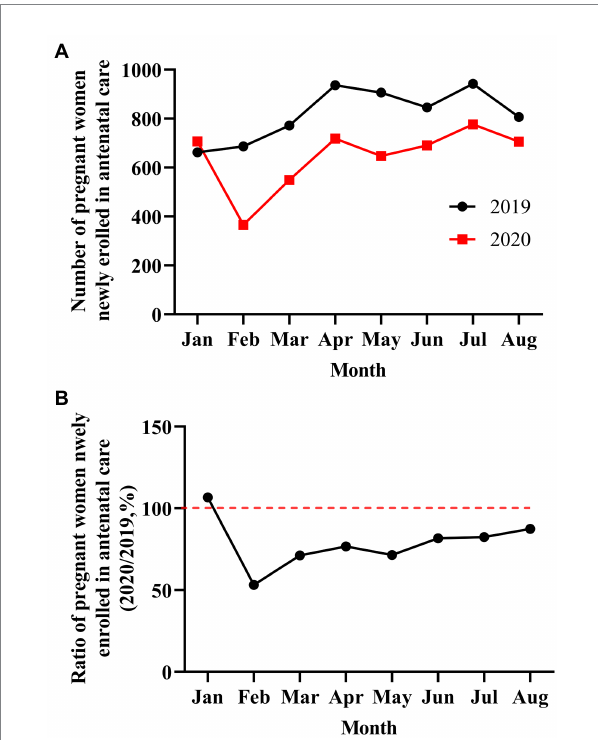
FIGURE 1 Number and ratio of pregnant women newly enrolled in antenatal care from January to August 2019 and 2020 (pre-and post- COVID-19 outbreak). (A) The number of pregnant women from January to August 2019 and 2020. (B) The ratio of pregnant women from January to August 2019 and 2020 (2020/2019,